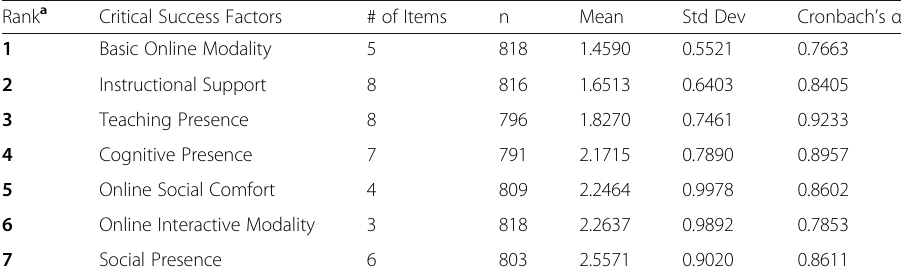
Table 3 Priorities of CSFs and Factor Reliability